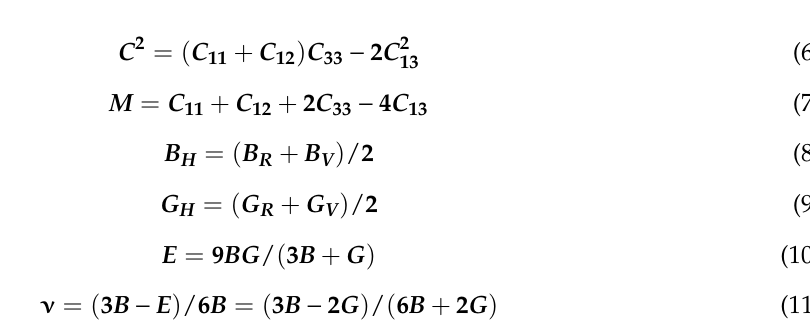
Table 3. B, G, E , and ν of the Ti 2 Cu intermetallic.